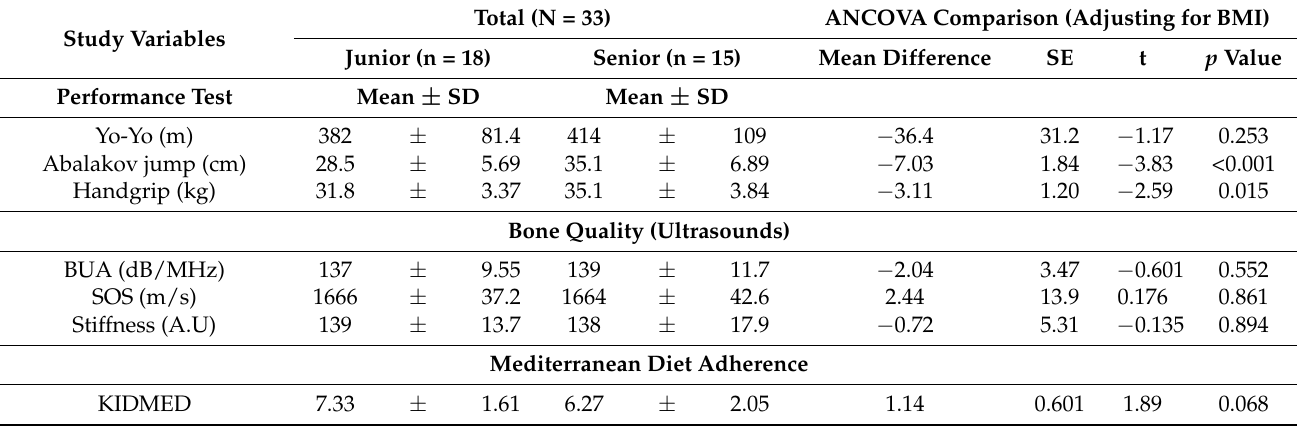
Table 2. Descriptive statistics for the KIDMED, performance tests, and bone mineral